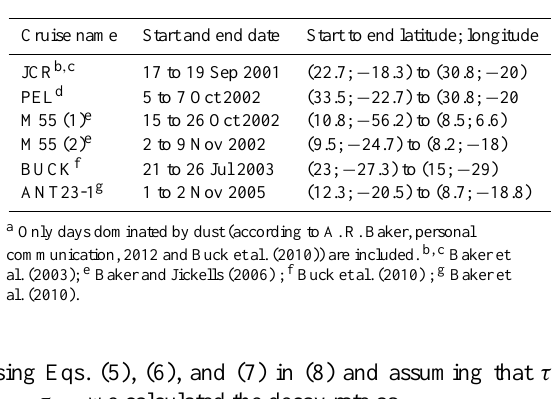
Table 3. Group G1 of cruises from which data have been used in this study a